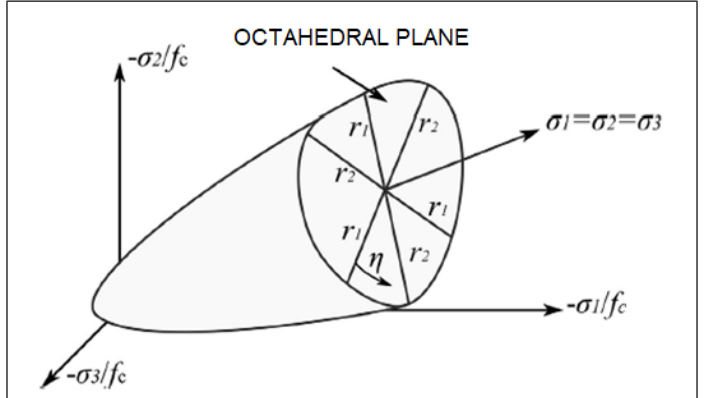
, and are principal 𝜎𝜎 1 𝜎𝜎 1 𝜎𝜎 2 𝜎𝜎 2 𝜎𝜎 3 𝜎𝜎 3